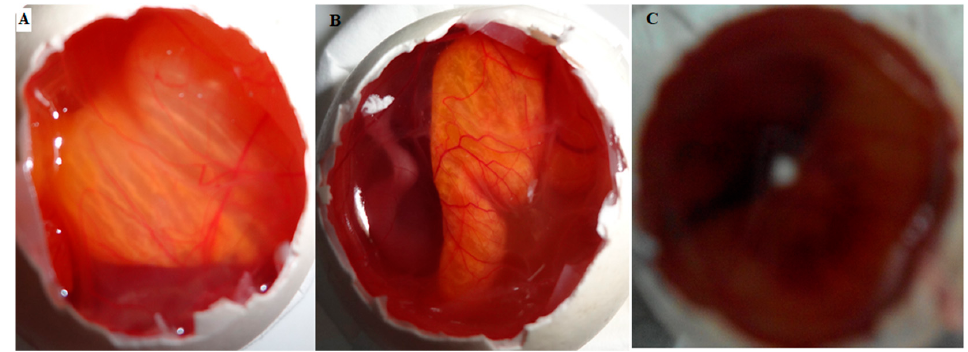
Figure 8. HET-CAM irritation test image treated with AM-NLopIG ( A ), 0.9% NaCl ( B ), and 1% SLS (C).